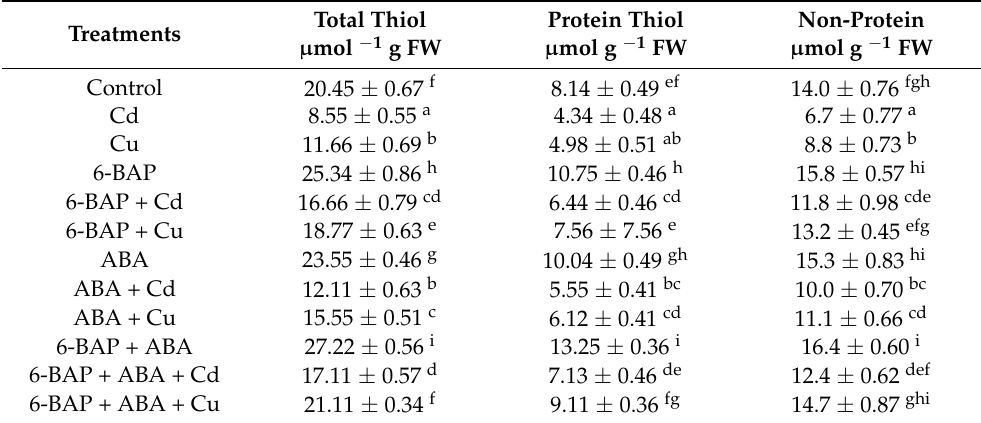
Table 4. The impact of 6-benzylaminopurine and abscisic acid, alone and in combination, on total thiol, protein thiol, and non-protein thiol in the one-year-old Pleioblastus pygmaeus , exposed to 100 µ M Cd as well as 100 µ M Cu. In this table, a, b, c, etc. letters revealed significant differences between control, 6-BAP, ABA, and co-application of 6-BAP + ABA in both combined and single forms with 100 µ M cadmium and 100 µ M copper based on Turkey’s test ( p < 0.05).